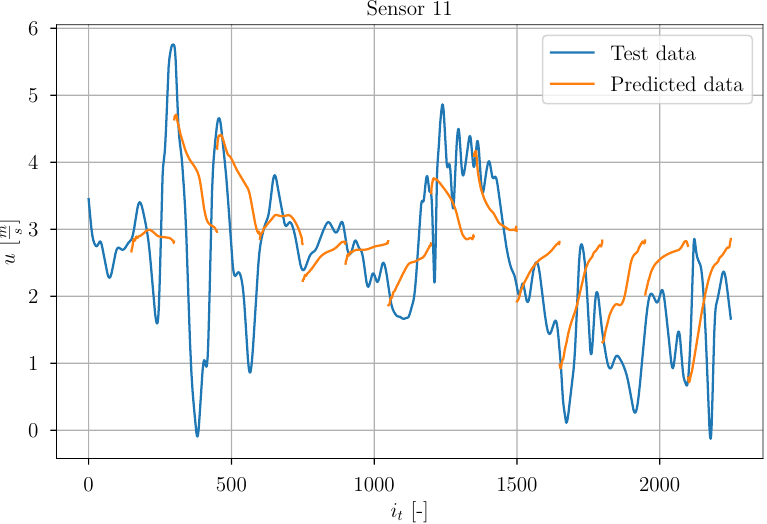
Figure 37. Predicted and true timeseries of sensor 11 for the standard setup. The presented data is discontinuous to illustrate the windows